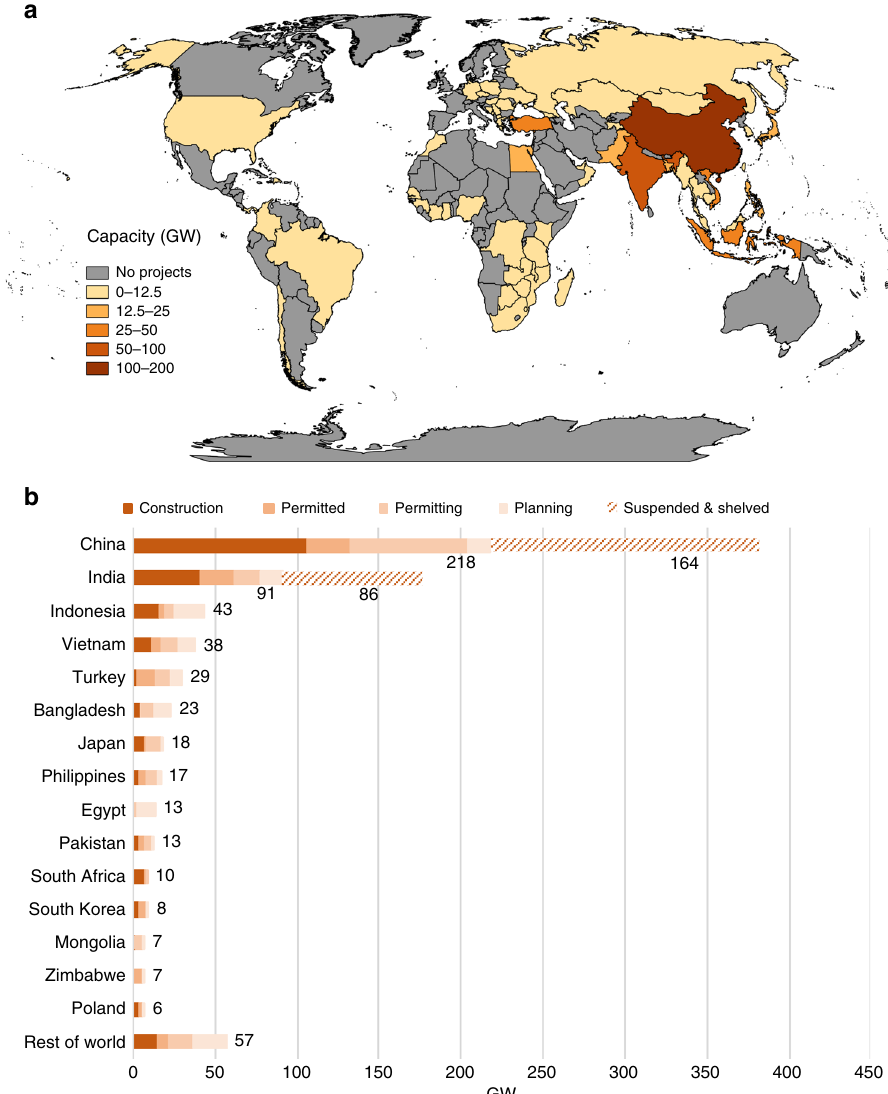
Fig. 1 Proposed coal capacity expansion. We fi nd a signi fi cant quantity of capacity in planning, permitting, and construction, shown globally ( a ) and by development stage for countries with the largest proposed additions ( b ). Calculations are based on the Global Coal Plant Tracker by Global Energy Monitor (July 2018) and primary, plant-level data collection for China, India, Indonesia, Japan, South Korea, and the US (Source data are provided as a Source Data fi